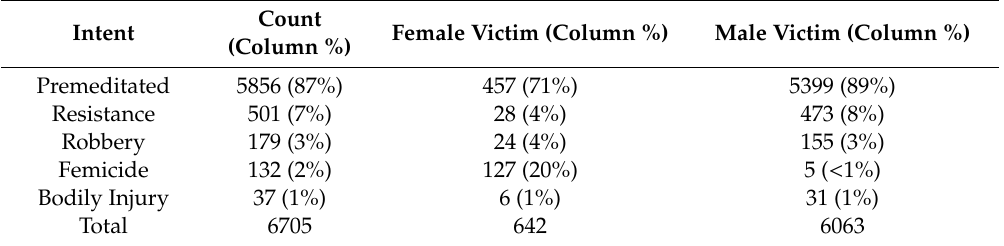
Table 1. Homicides grouped by intent for the state of Alagoas, Brazil between 2016 and